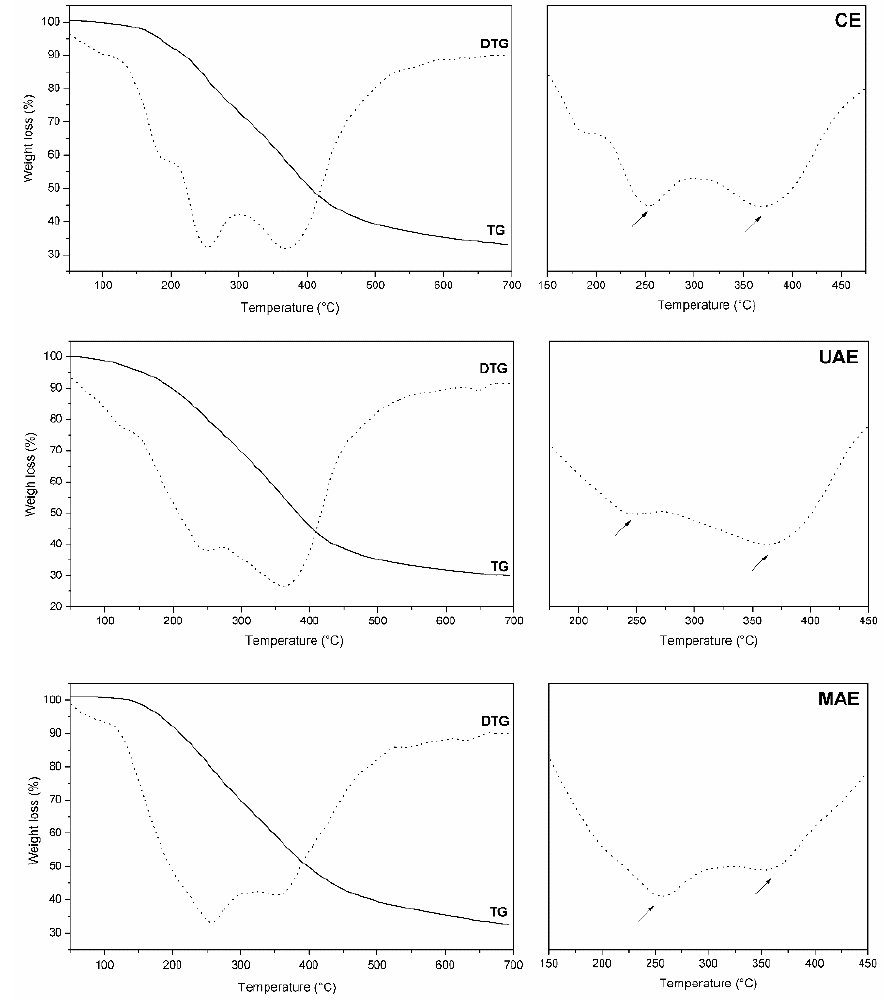
Figure 3. TG/DTG profiles of Nectandra grandiflora extracts obtained by different techniques. CE: Conventional Soxhlet extraction; UAE: Ultrasound-assisted extraction; MAE: Microwave-assisted extraction. The arrows indicate the temperatures where the greatest mass loss occurred.